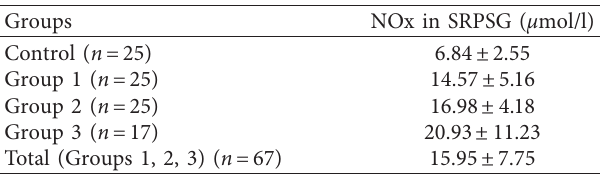
Ta ble 3: Patients distribution according to the results of